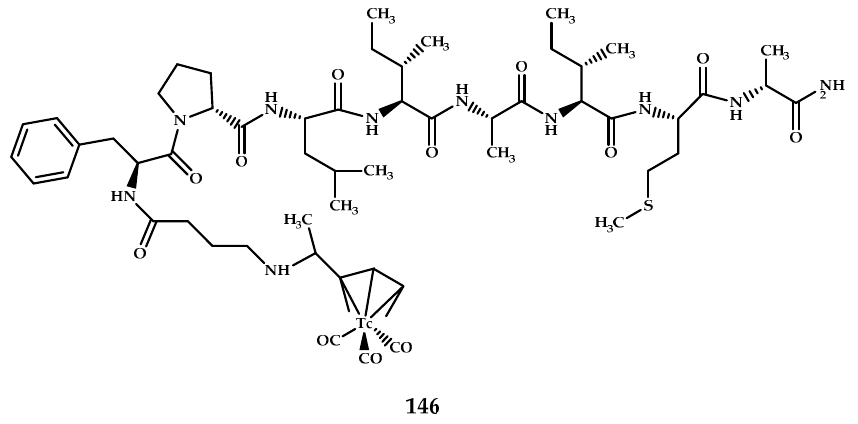
Figure 35. 99m Tc-Cp-GABA-D-(FPLIAIMA)-NH 2 148 based on an A β -a ffi nitive peptide sca ff old, designed for SPECT imaging of A β